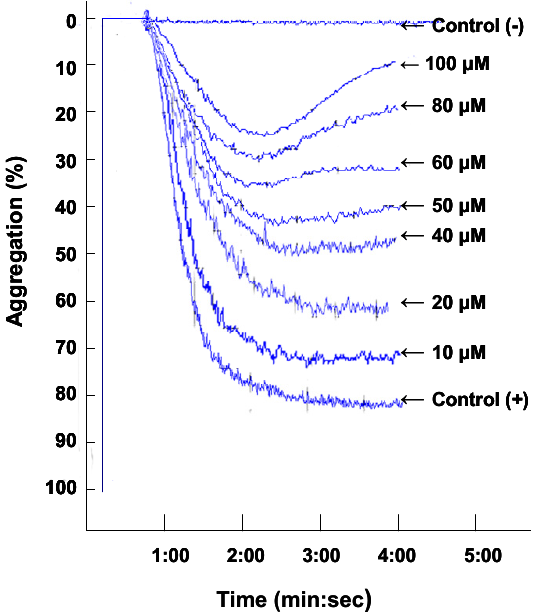
Figure 4. Representative aggregation curves illustrating the inhibitory effect of different concentra- tions of 4 ′− DHA-apigenin hybrid on platelet aggregation induced by TRAP − 6.